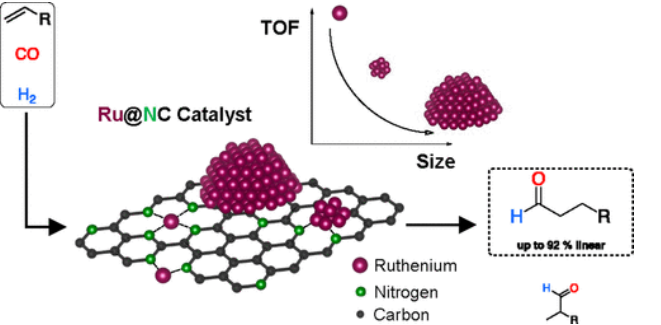
Figure 13. The hydroformylation of olefin by Ru@NC catalyst. Reprinted with permission from Ref. [41]. Copyright © American Chemical Society 2022.